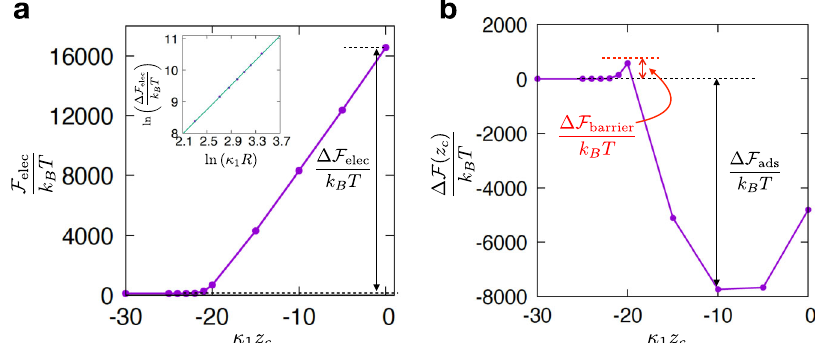
Fig. 2 Free energy for an RNA virus approaching an air-water interface. a Approach curve showing the increase in electrostatic free energy F elec ð z c Þ = k B T as a function of distance to the air-water interface. Parameters are as speci fi ed in the text. Inset: scaling of the electrostatic free energy increase Δ F ¼ F ð 0 Þ (cid:2) F ð κ z ! (cid:2)1Þ in units of k B T as a function of dimensionless radius of the virion, κ c elec elec elec 1 close to the predicted value of 2, see Supplementary Note 3. b Plot of the total (electrostatic plus Pickering) free energy change, Δ F ð κ z Þ ¼ F ð κ z Þ (cid:2) F ð κ z ! (cid:2)1Þ , as a virion approaches an air-water interface ( γ = 70 mN/m). The electrostatic free energy barrier Δ F c c c 1 1 1 adsorption free energy gain Δ F ads are shown in the plot.